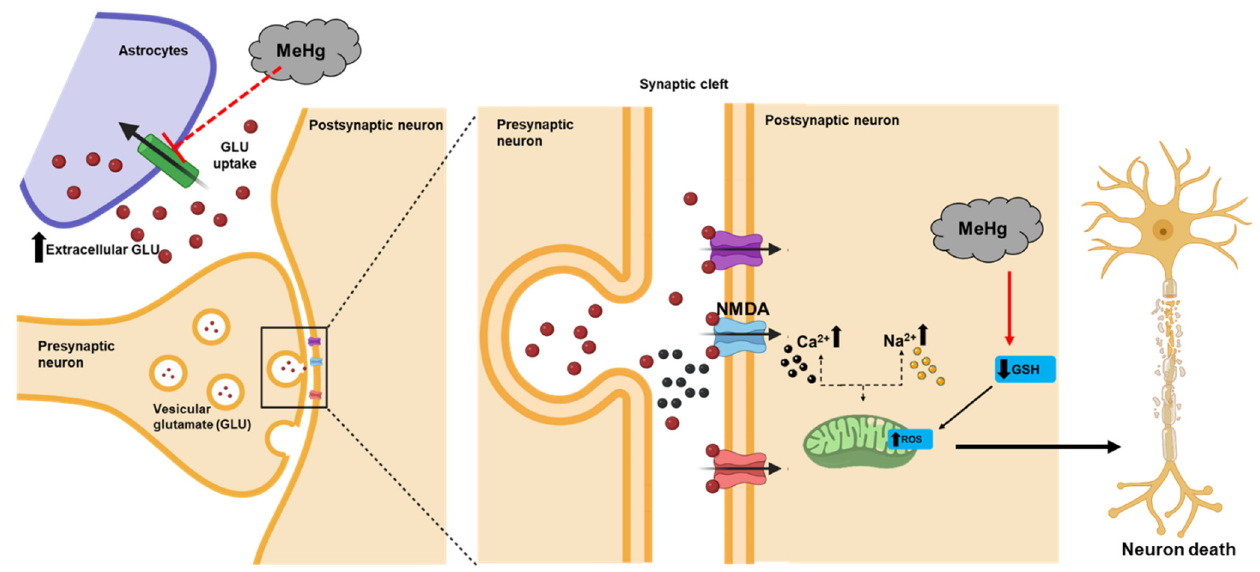
Figure 3. MeHg-induced glutamate and Ca 2+ dyshomeostasis and oxidative stress involving neuronal death. MeHg inhibits astrocytic glutamate uptake and enhances glutamate release from presynaptic terminals. The increased extracellular glutamate levels lead to the overactivation of N-methyl-D- aspartate (NMDA)-type glutamate receptors, enhancing the influx of Ca 2+ into postsynaptic neurons. The increased levels of intracellular Ca 2+ may cause mitochondrial dysfunction and increased reactive oxygen species (ROS) formation. MeHg disrupts the redox state of the cells, which indirectly depletes glutathione (GSH), which will further increase ROS production in both astrocytes and